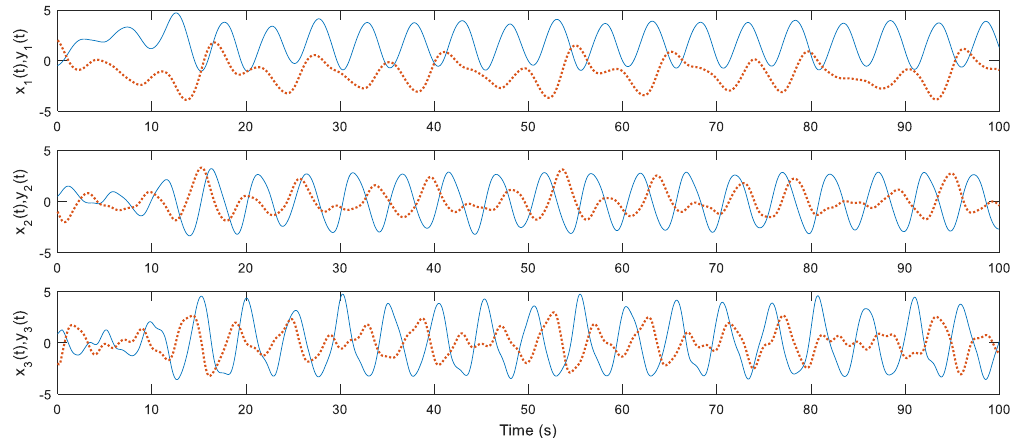
Figure 2. Representation of the dynamics of the master and slave systems (25), (26) without the controller. Solid lines are the dynamics of the master system and dotted lines are the dynamics of the slave system.